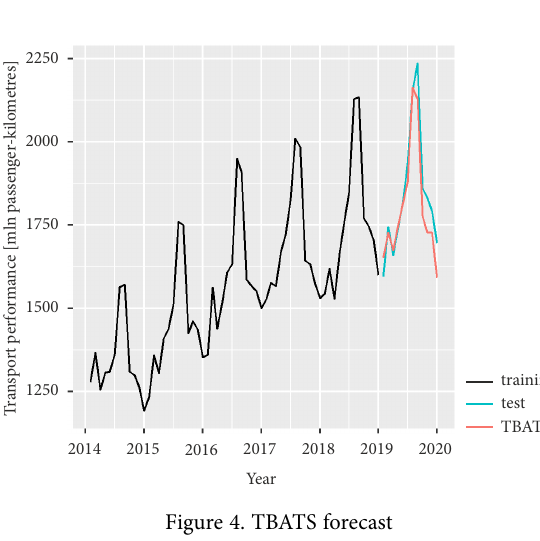
Figure 1. Observations divided into a test set and a training set Figure 2. Naive forecast